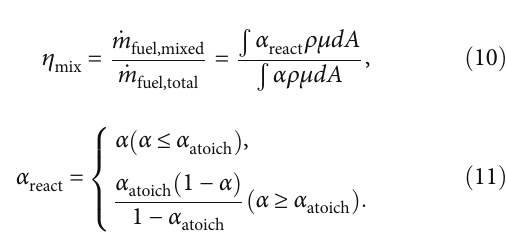
Figure 10: Mass fraction contour and streamline diagram of case A and cases D - F at di ff erent planes. (a) x = 70 mm . (b) x = 75mm . (c) x = 80mm distance.